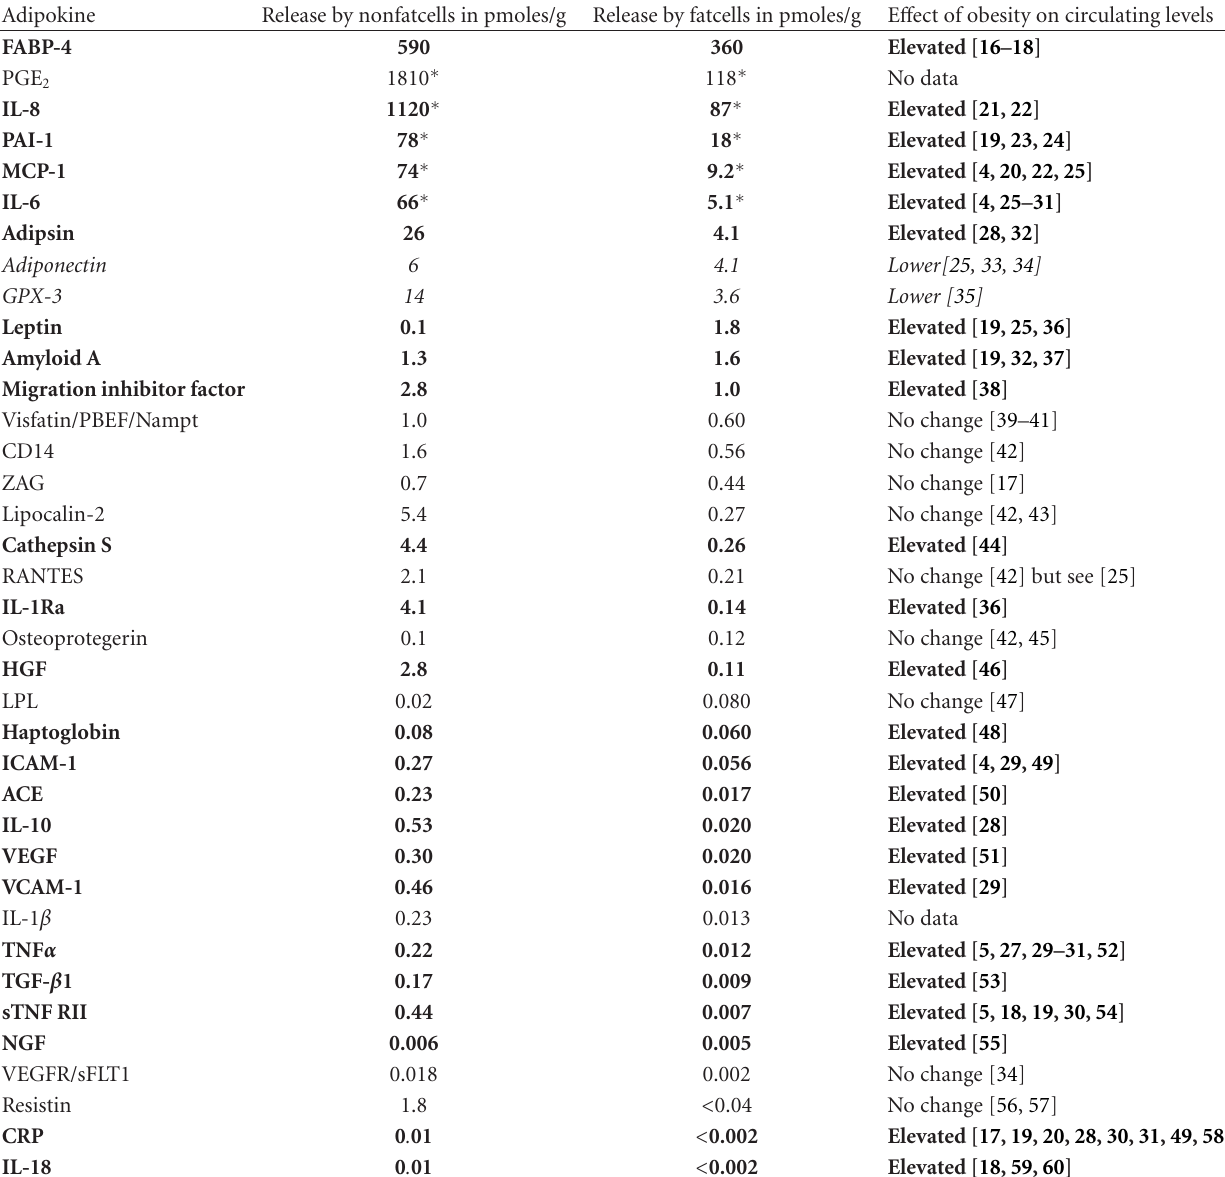
Table 1: Comparison of release of 37 adipokines by fat cells as compared to the other cells in human adipose tissue ranked by fat cell release along with the e ff ect of obesity on their circulating levels in